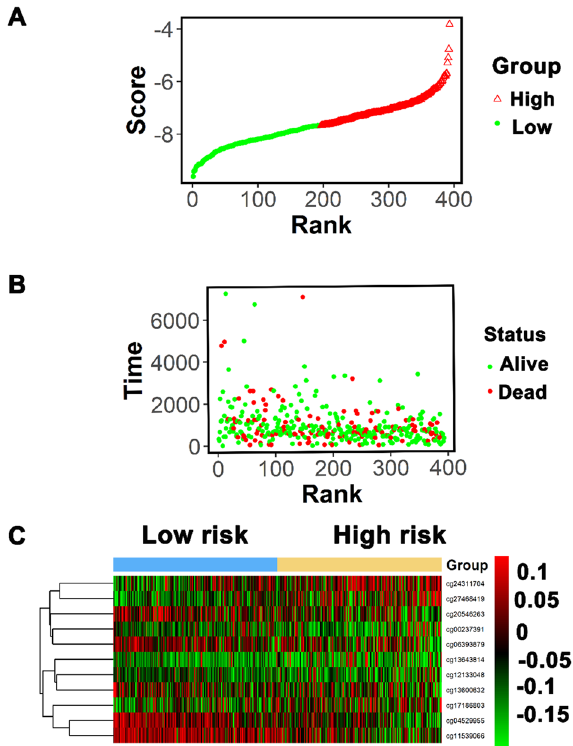
Figure 5. Methylation risk score analysis of 393 stage I–II LUAD cases in the entire TCGA dataset. ( A ) Methylation risk score distribution against the rank of risk score. The red triangle represented the high-risk samples, the green ball represented the low-risk samples. ( B ) Survival status of stage I–II LUAD patients against the rank of risk score. The green ball referred to alive samples, the red ball referred to the dead samples. ( C ) Heatmap showed 11 methylation sites profiles in low- and high-risk groups. Each row of the heat map represented a profile of a methylation